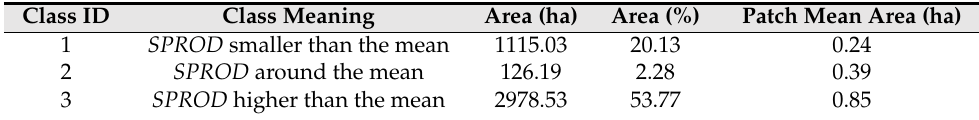
Table 8. Areal metrics about SPROD values of vegetated areas in Torino. Area values and percentages refer to those patches showing a stable behavior in terms of SPROD anomaly along the 3 investigated years. These, globally, size the 76.18% of the whole vegetated area of the city (5540.11 ha). Class ID Class Meaning Area (ha) Area (%)